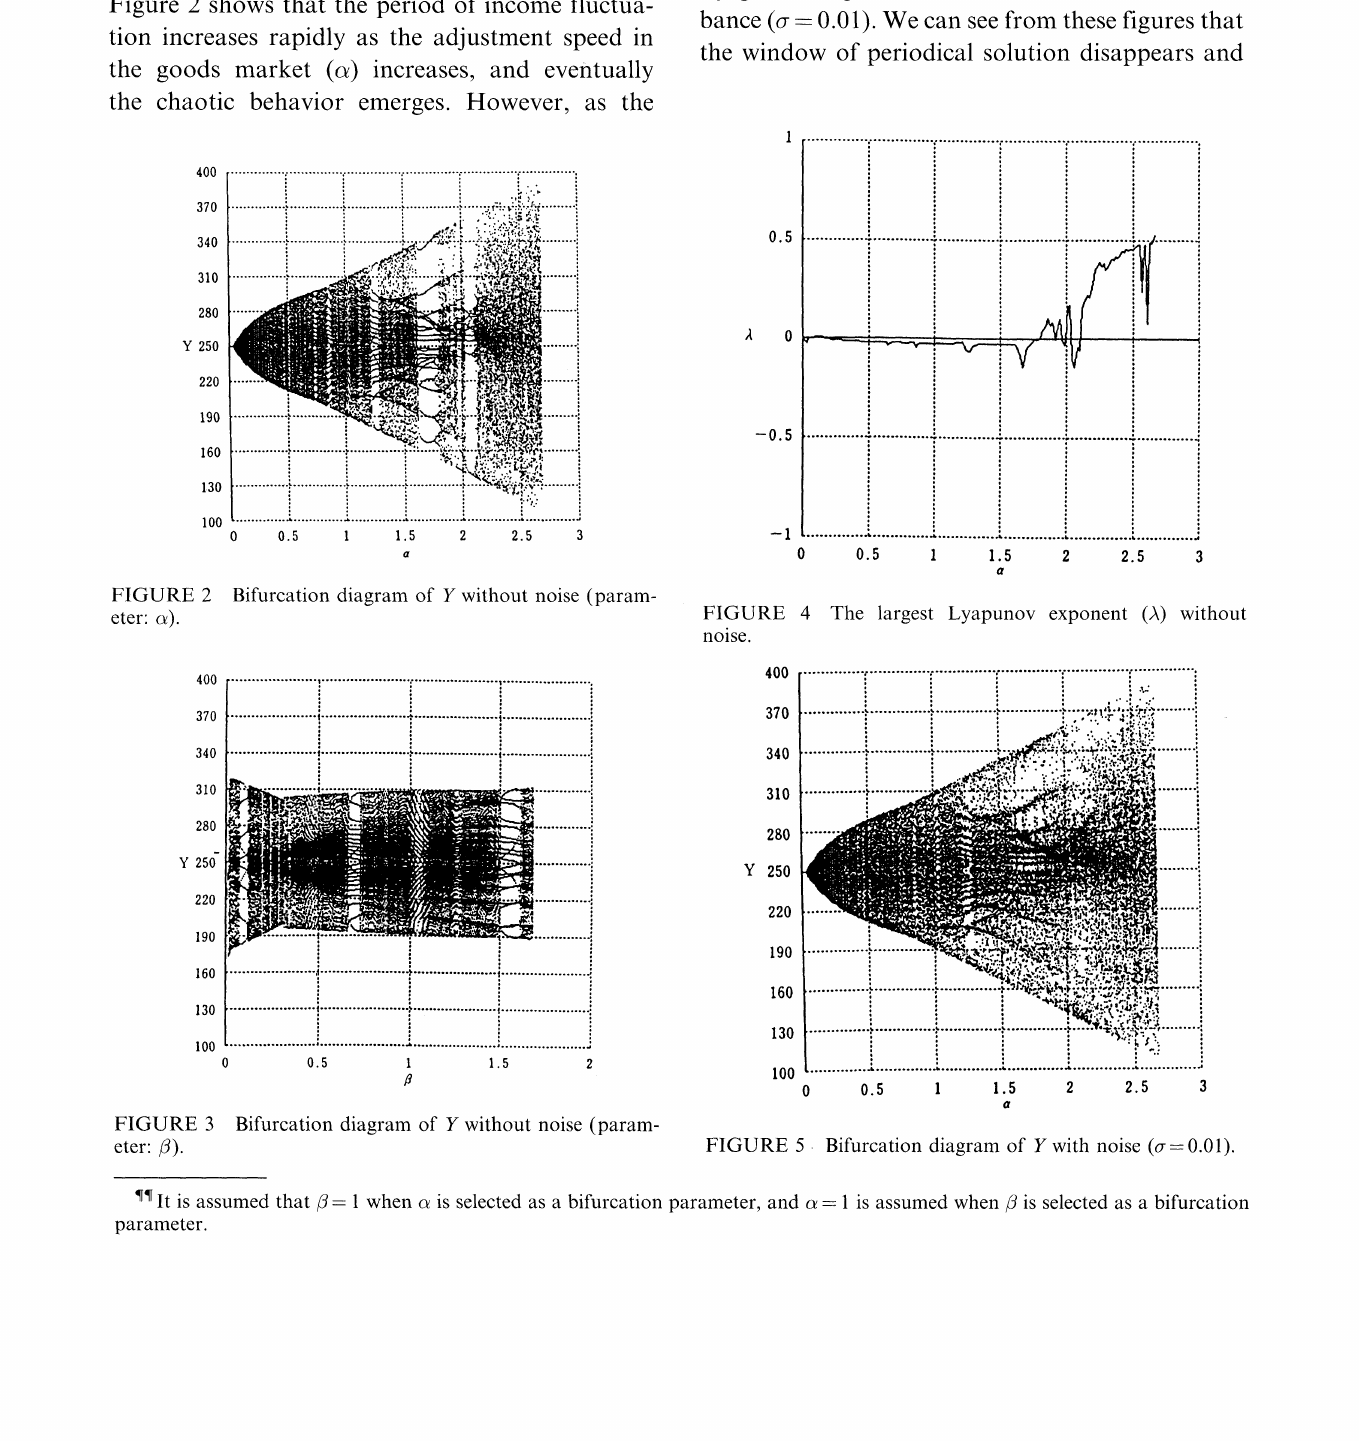
FIGURE 3 Bifurcation diagram of Y without noise (param- eter: ). FIGURE 5. Bifurcation diagram of Y with noise